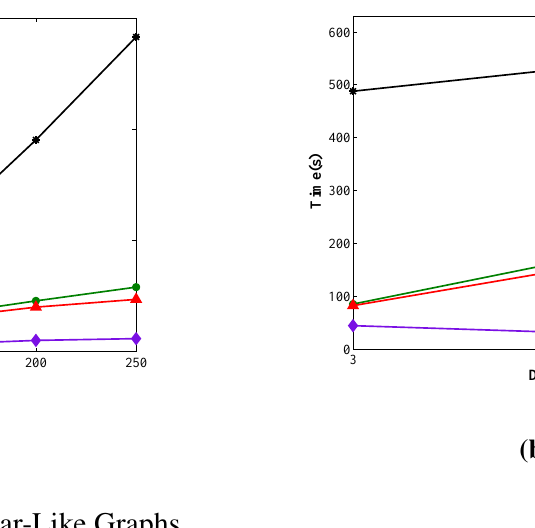
Figure 19. Comparisons between algorithms in terms of wall clock times. ( a ) Wall clock times against node count; ( b ) wall clock times against degree.